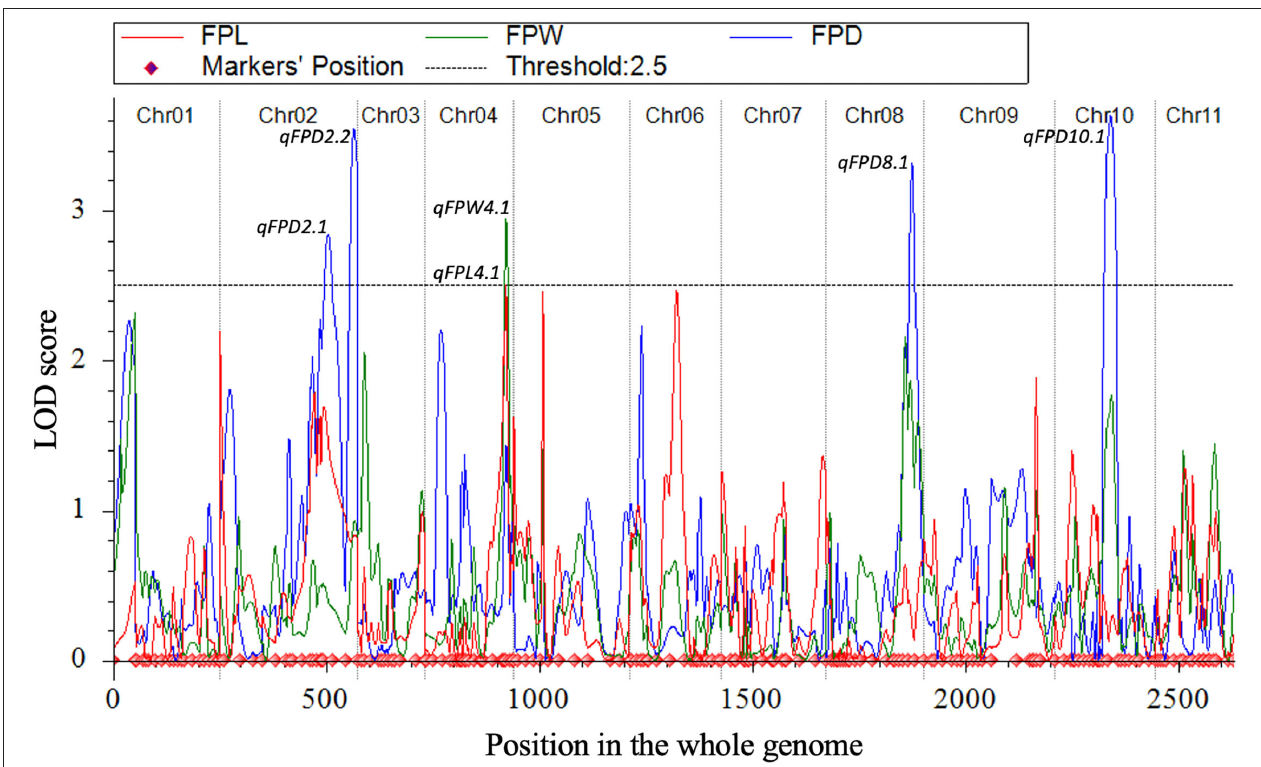
FIGURE 7 | All LOD score profiles of mapped QTLs for FP traits and their genetic positions in the whole-genome.